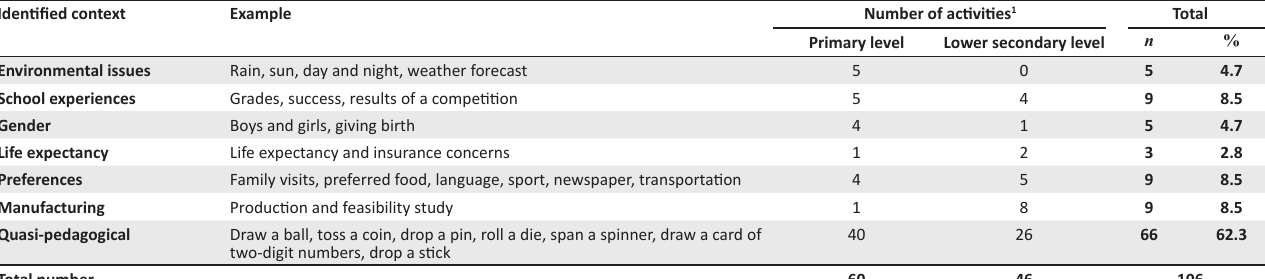
TABLE 2: The probability contexts within the Egyptian school curriculum. Identified context